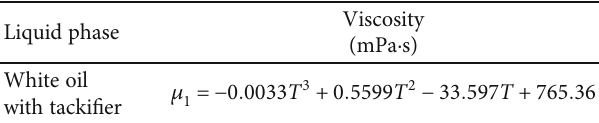
Figure 1: The multiphase fl ow test system. Table 1: Viscosity vs. temperature of the liquid